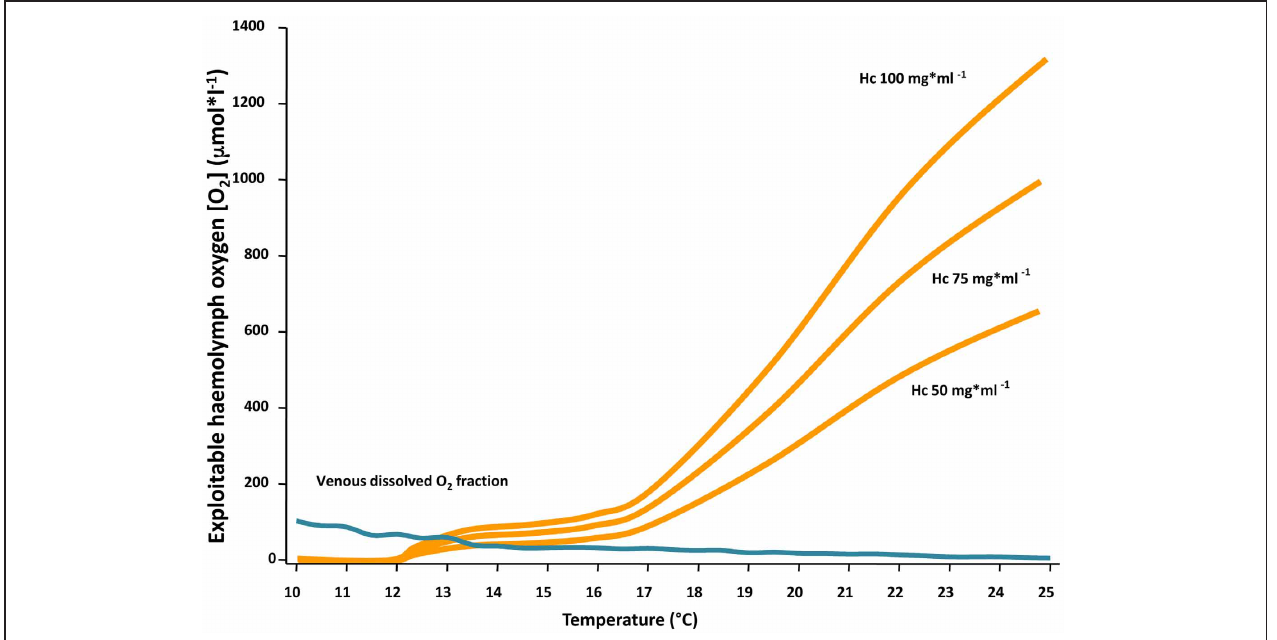
FIGURE 7 | Contribution of the physically dissolved fraction of oxygen (blue line) and the amount released by haemocyanin (Hc) in the venous blood (orange lines) to cover whole animal oxygen demand at various temperatures. Note that under control conditions and moderate warming (10–13 ◦ C) haemocyanin remained fully saturated and did not contribute to oxygen delivery. Between 13 and 18 ◦ C, when venous P O 2 decreased significantly, haemocyanin started to release oxygen and compensated for the reduction of dissolved oxygen levels. At the highest temperature (18–25 ◦ C), when the venous dissolved O 2